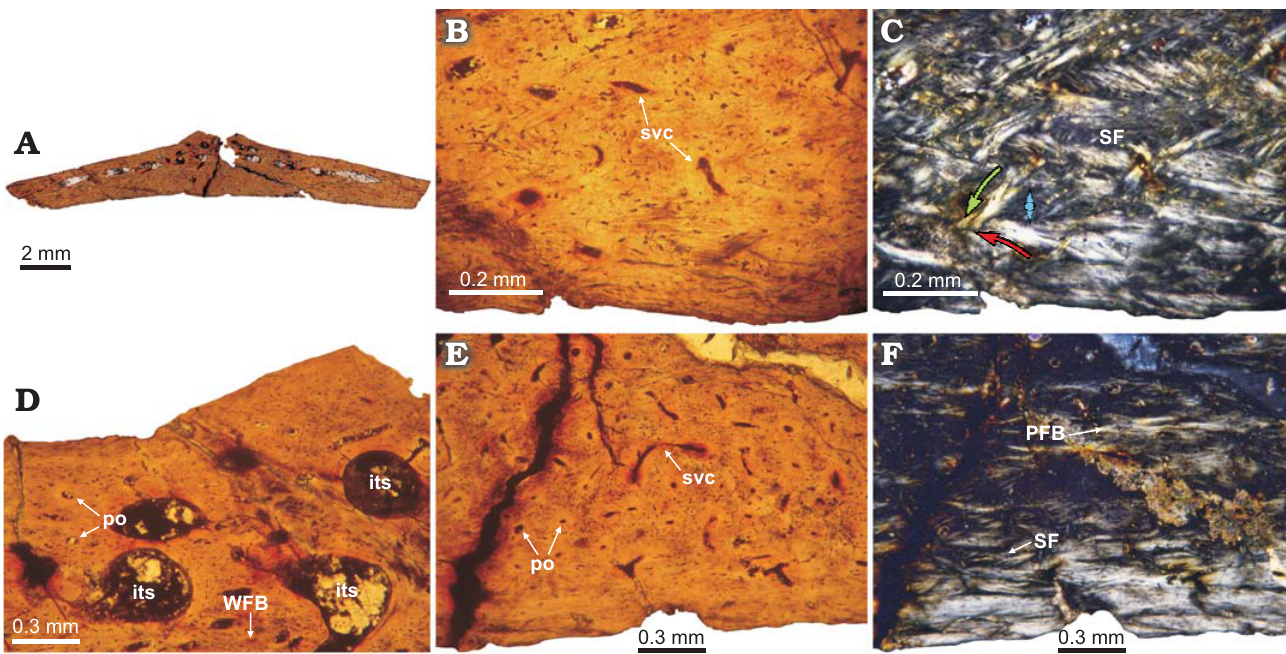
Fig. 6. Histology of osteoderm V2 of doswelliid Vancleavea campi Long and Murray 1995, H4-102-08 from Hayden Quarry, Petrified Forest Member, Chinle Formation, New Mexico, USA, Early Norian. A . Complete transversal section view. B , C . Detail of the basal cortex, which is poorly vascularized with some simple vascular spaces. Structural fibers are best observed under cross-polarized light. The arrows in C indicate the orientation of the fiber bundles. D . Detail of the external cortex and vascular spaces of the inner region. E , F . Detail of the basal cortex toward the marginal zones. In these areas, the presence of structural fibers is not as clear. A, B, D, E, normal light; C, F, cross-polarized light. Abbreviations: LB, lamellar bone; PFB, parallel fibered bone; po, primary osteon; re, resorption space; SF, structural fibers; svc, simply vascular canal; WFB, woven-fibered